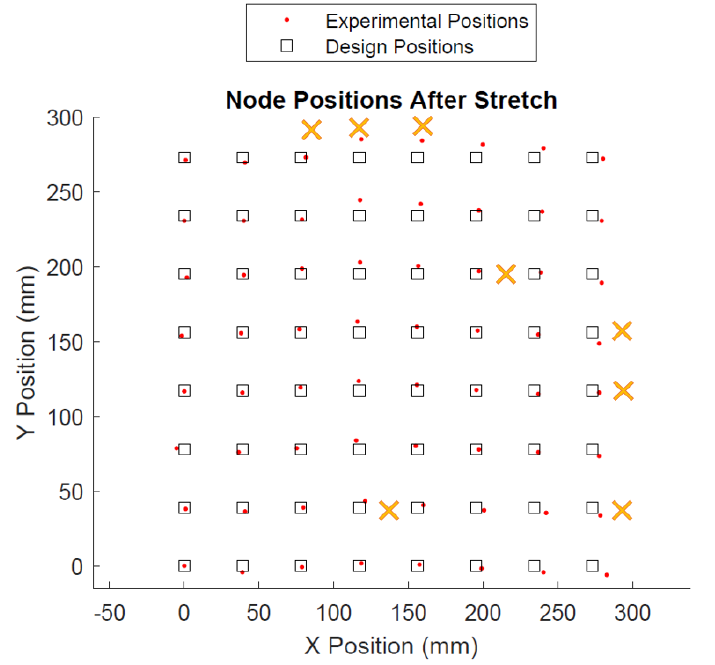
Figure 17. Node positions after Run 1. Xs indicate locations of unopened sacrifice